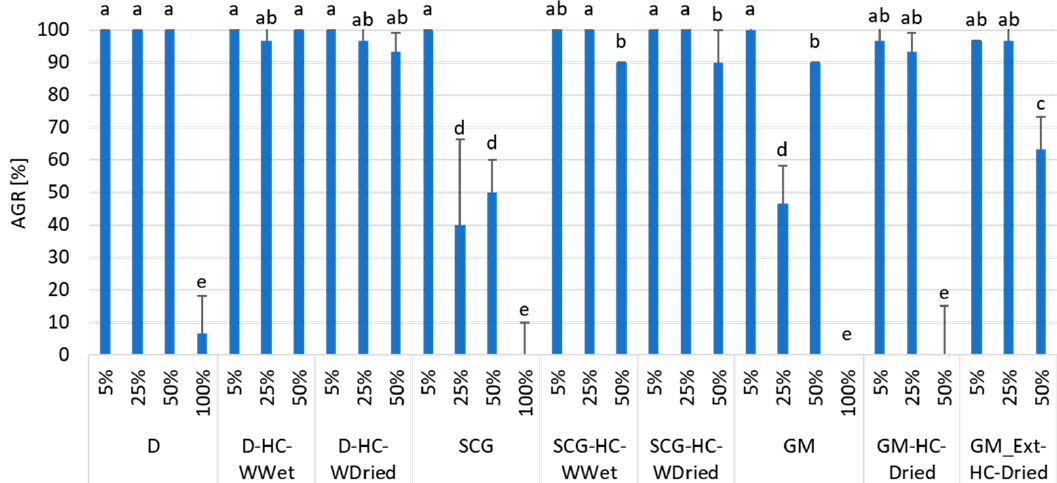
Figure 3. Average germination rates (AGR) assessed for the different hydrochars and their related feedstocks. The results are expressed relative to the peat controls (100%). Samples connected by the same letters are not significantly different.